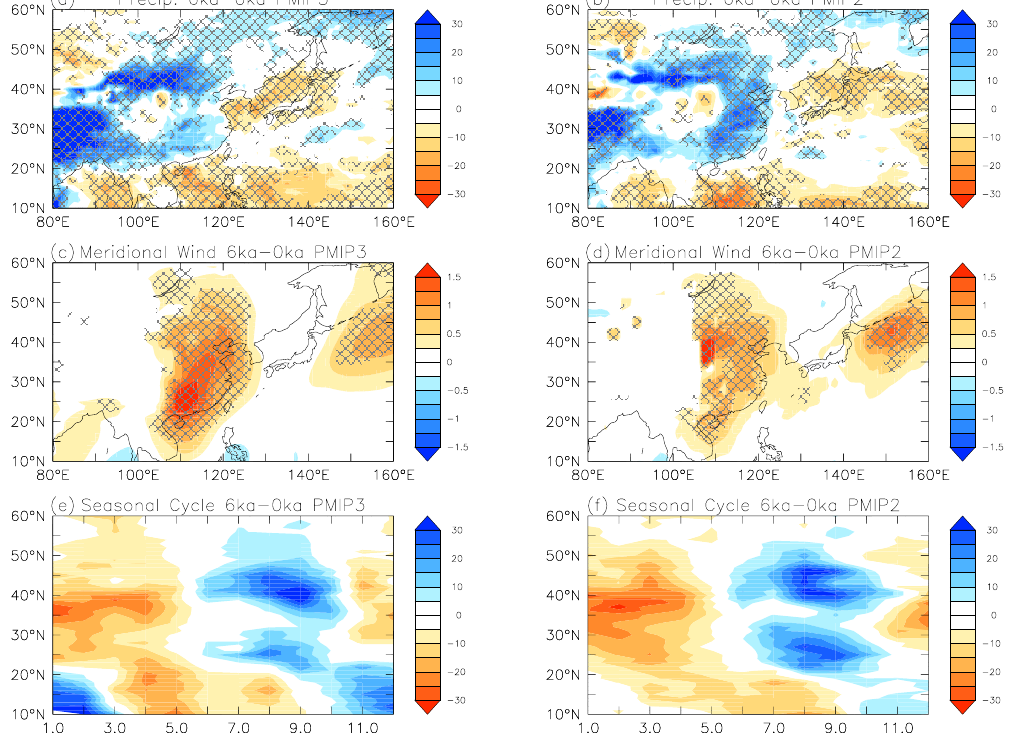
Fig. 4. Changes of EASM characteristics for the PMIP3 model median (left column) and the PMIP2 model median (right). (a) and (b) the summer precipitation (in %); (c) and (d) the meridional wind at 850hpa of JJA (positive northward, ms − 1 ); (e) and (f) the seasonal cycle of monsoonal precipitation (in %). The shadow indicates areas where the model median exceeds 1.2 times of the inter-model standard deviation (1.2 σ ), which indicates the significance of the